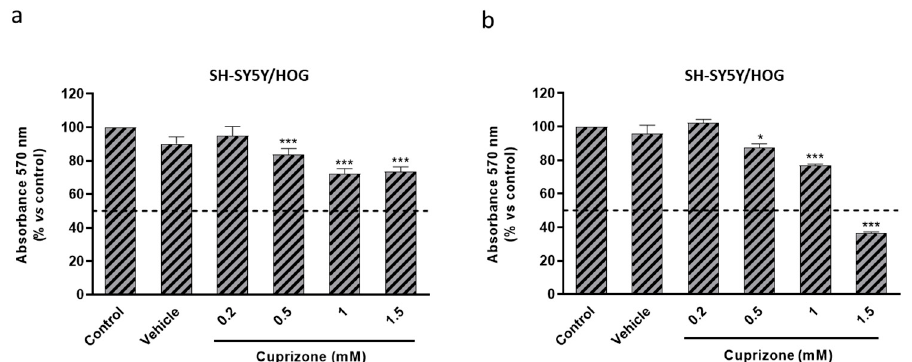
Figure 5. MTT reduction assay in SH-SY5Y/HOG co-cultures treated with increasing concentrations of CPZ (0.2–1.5 mM) for 24 ( a ) and 48 h ( b ). Cell damage is represented as the percentage of MTT reduction versus control. Data are the mean ± S.E.M of five independent experiments. Significant differences were analyzed by a one-way ANOVA followed by post-hoc Tukey’s test. * p < 0.05, *** p < 0.001 compared to control.